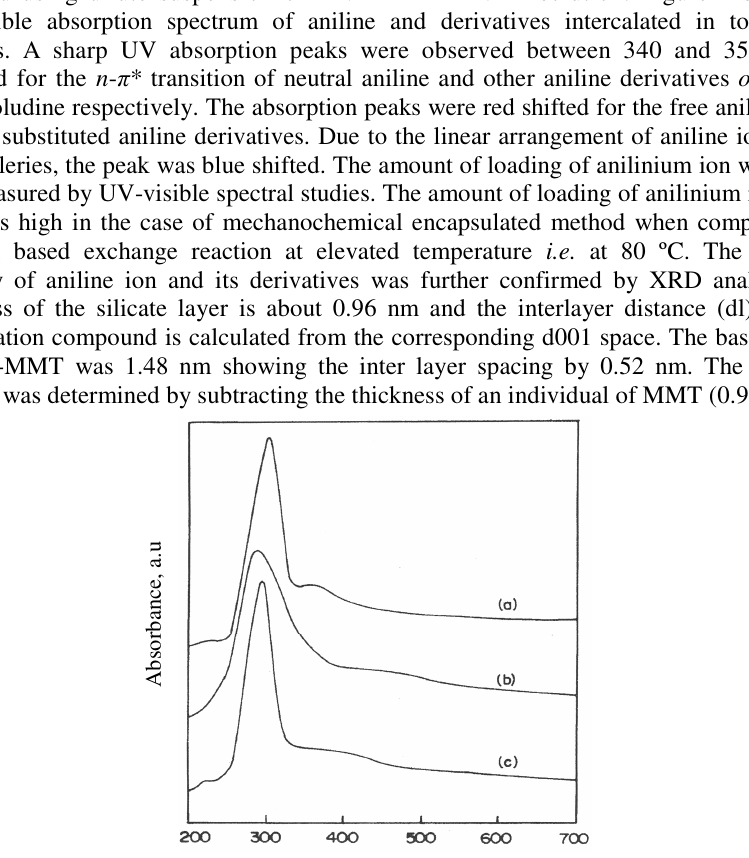
) S O Two 4 2 2 8.